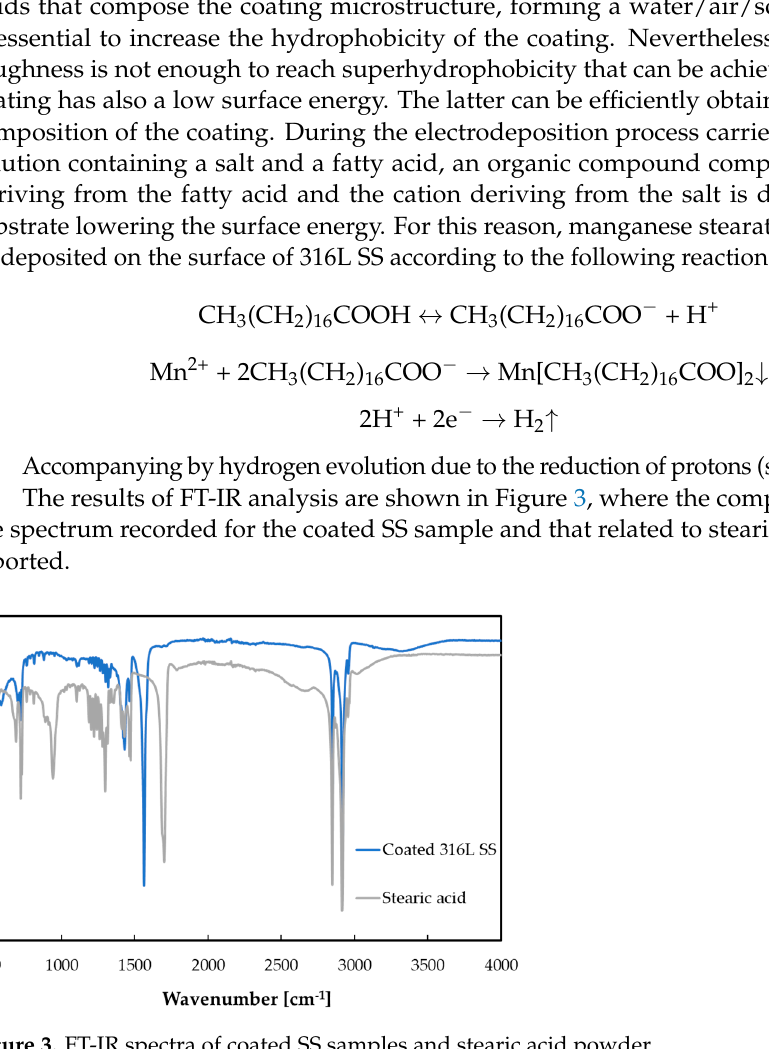
Figure 3. FT-IR spectra of coated SS samples and stearic acid powder. Absorption bands at 2914 cm − 1 and 2847 cm − 1 are present in both spectra and they can be attributed to -CH- asymmetric and symmetric stretch vibration, respectively [16,17]. Thus, the coating fabricated through electrodeposition contains these C-based groups.